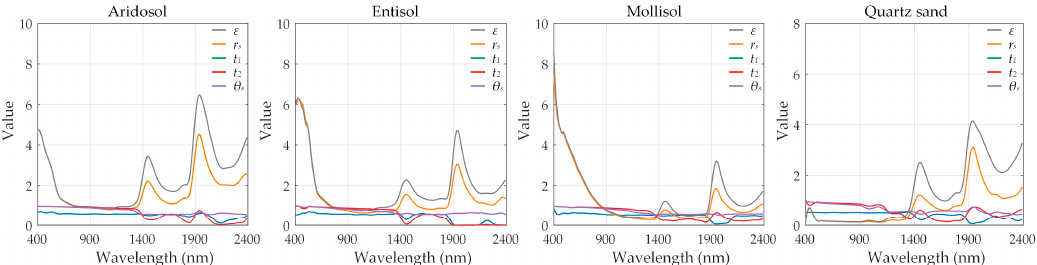
ε , r θ s , t 1 , t 2 , and s ) of the six soils at di